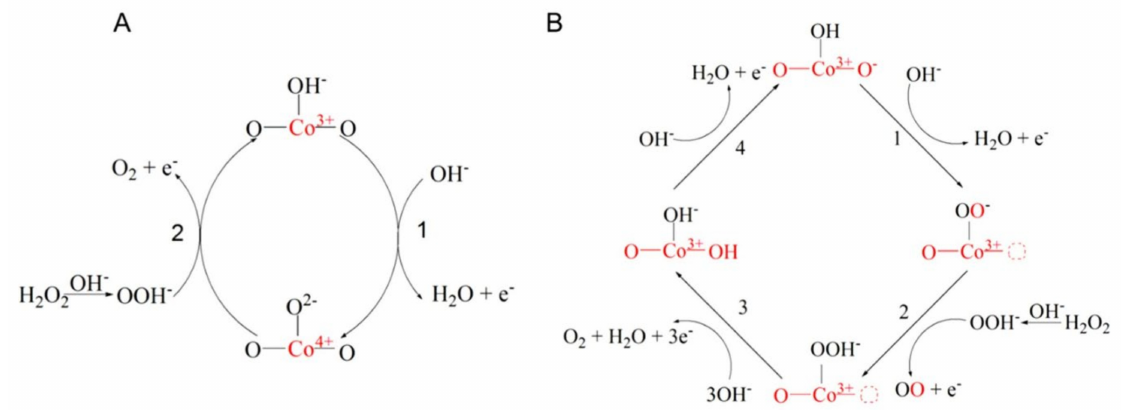
Figure 3. Electro-oxidation mechanisms of H 2 O 2 on La 0.6 Sr 0.4 CoO 3- δ that occur simultaneously via the Co 3+ /Co 4+ redox couple ( A ) and lattice-oxygen-mediated oxygen evolution reaction (LOM-OER) ( B ) involving oxygen vacancies and superoxide ion (O 22 − /O − ) [32]. Reproduced with the permission from